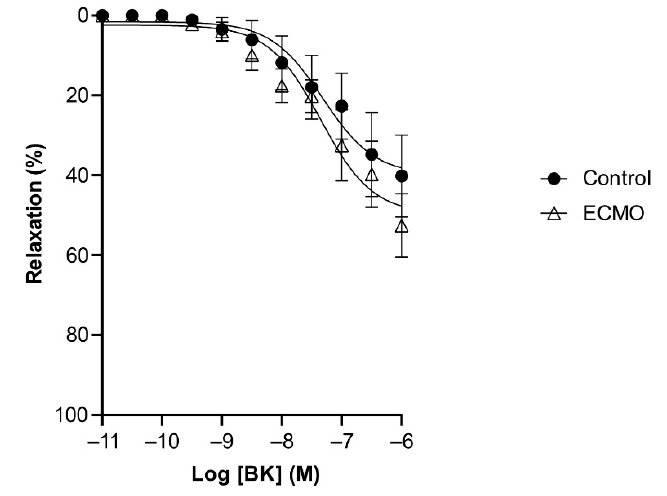
Figure 6. Relaxation in response to bradykinin (BK) in the presence of L-NAME showed no difference in coronary artery rings of control and ECMO groups. Cumulative dose–response curves to BK in the presence of L-NAME in porcine coronary artery rings in control and ECMO group. Vessels were precontracted with U46619 (1 μ M). Data points are presented as mean ± S.E.M ( n = 5 in both groups). ECMO: extracorporeal membrane oxygenation.